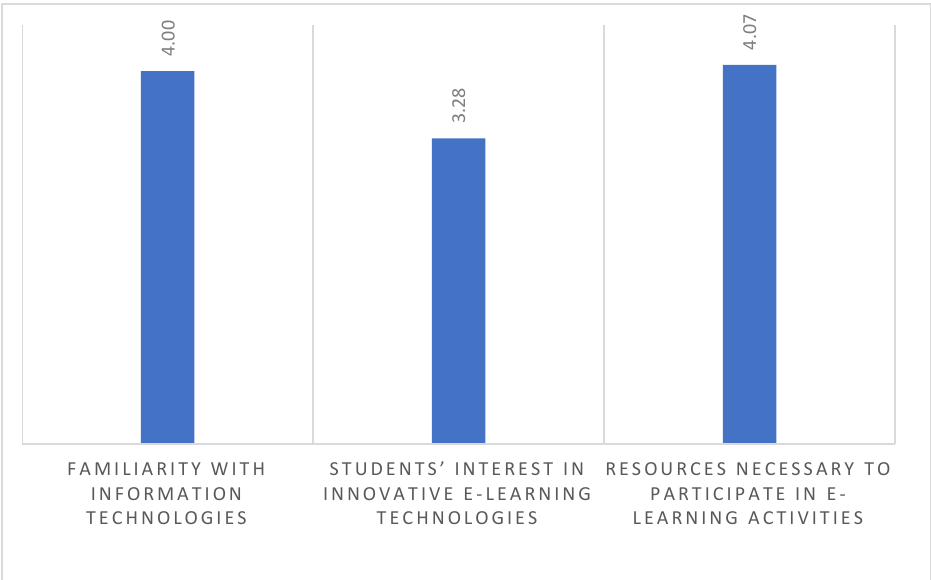
Figure 9. Assessment of familiarity, interest, and the possibility of using e-learning technologies.